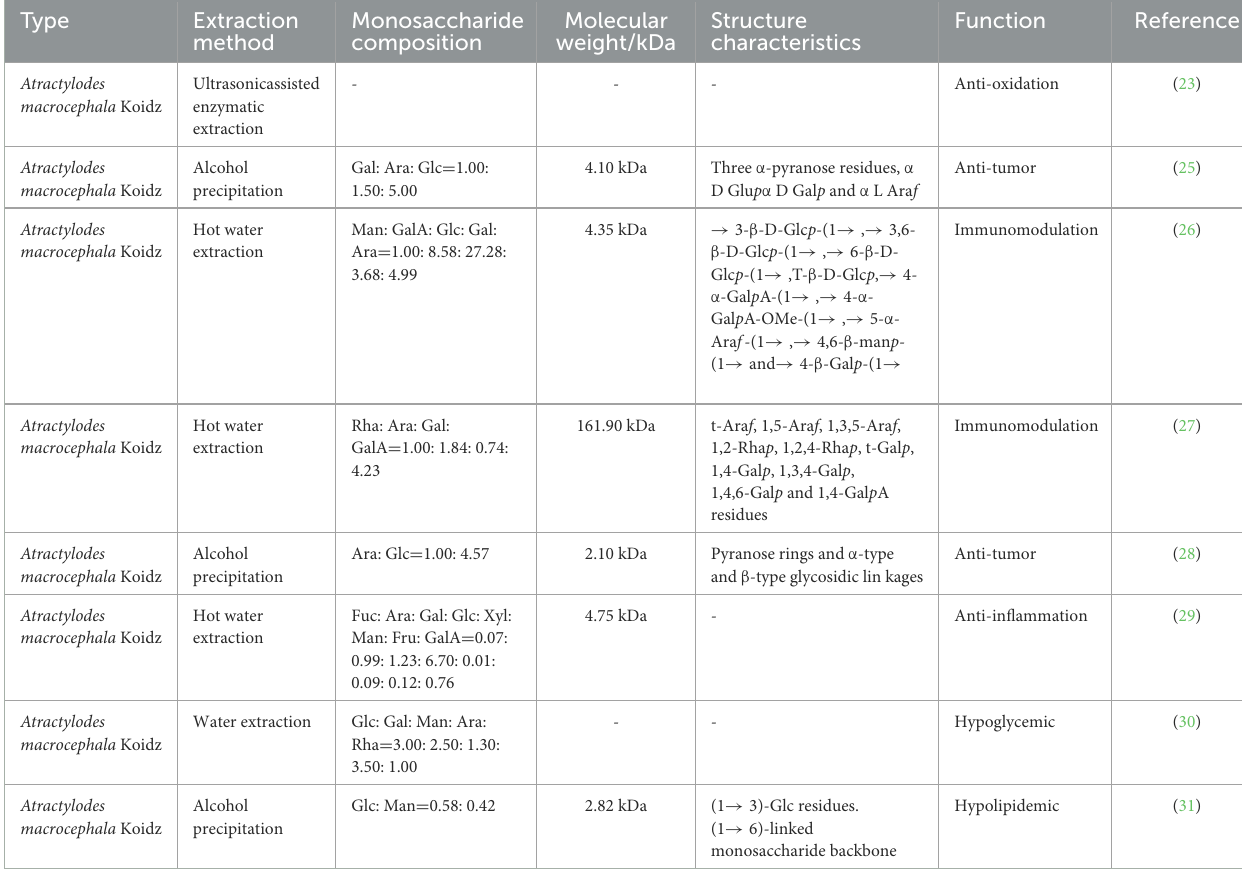
TABLE 1 Structure and structure-activity-relationship of polysaccharide from Atractylodes macrocephala Koidz.